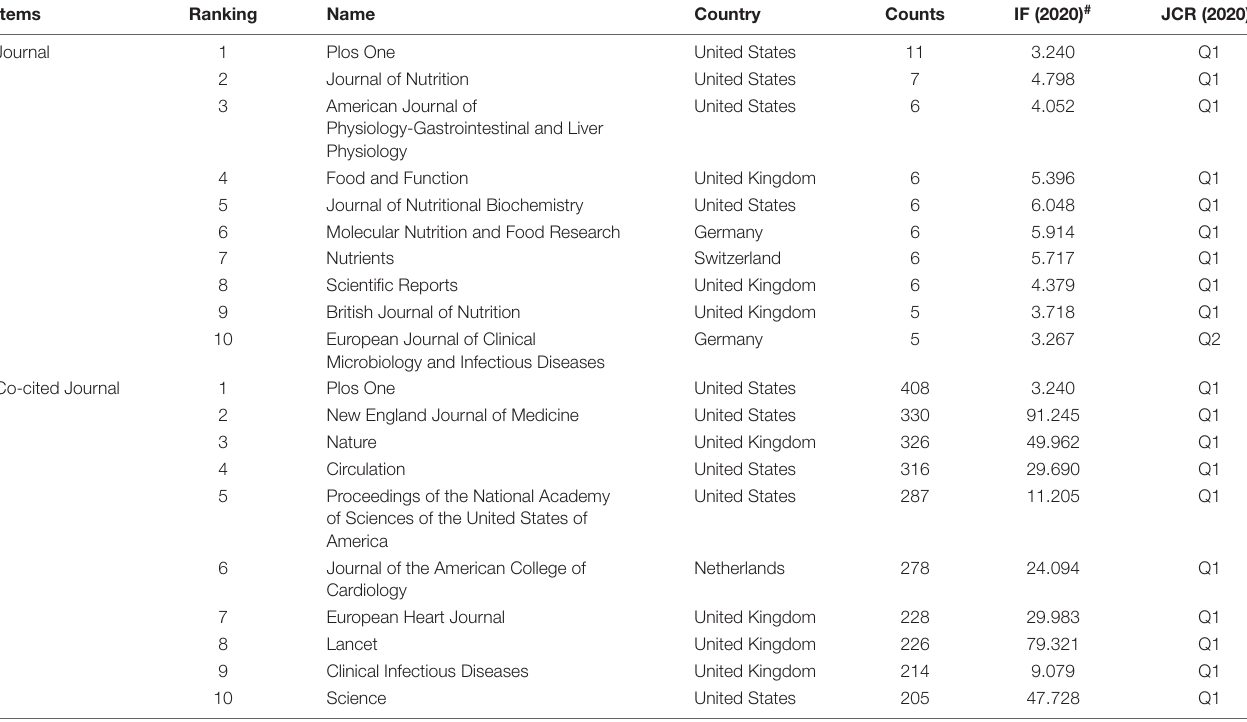
TABLE 2 | Ranking of the top 10 journals and co-cited journals for gut microbiota research in the heart failure field. Items Ranking Name Country Counts